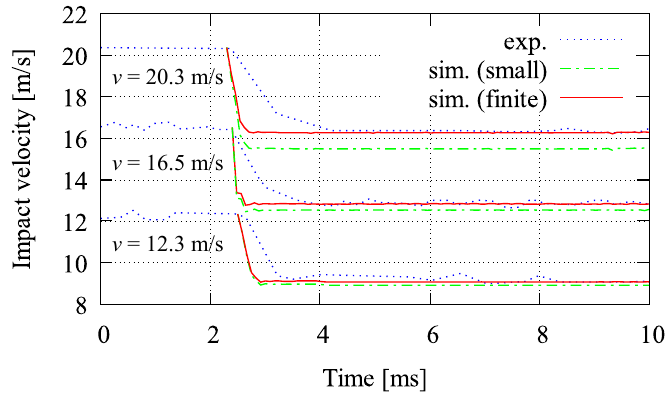
Figure 25. Velocity-time curves reported in [48] compared to small and finite strain simulations for three different velocities of 12.3 m/s, 16.5 m/s, and 20.3